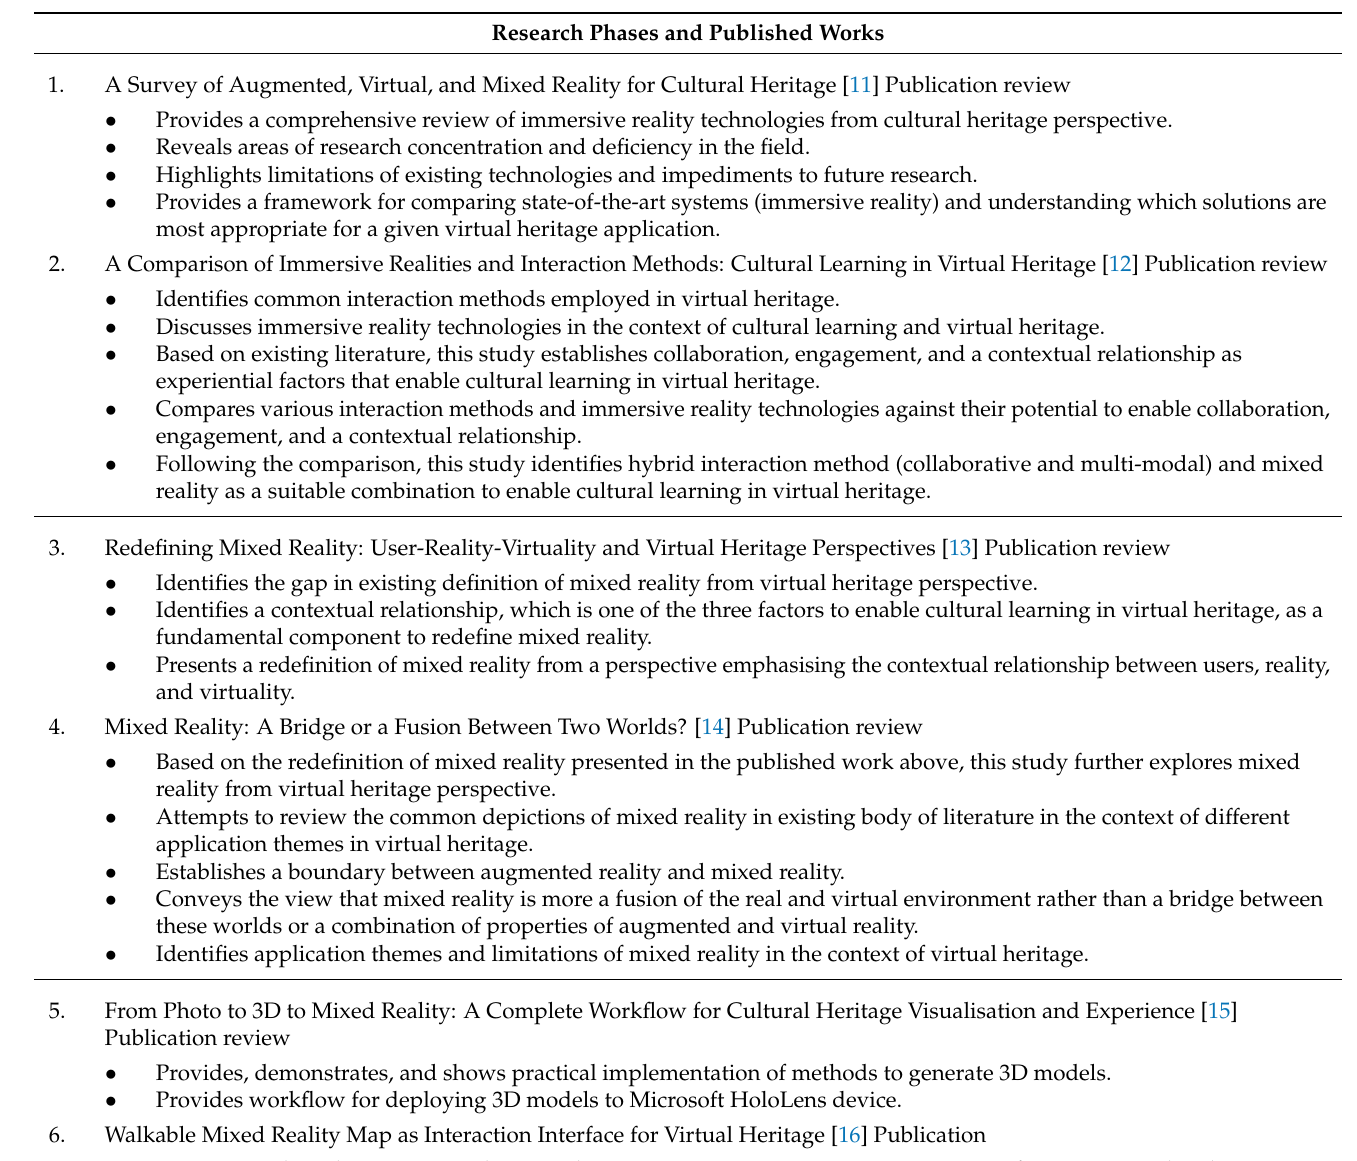
Table 1. Summary of previous publications that led to this this